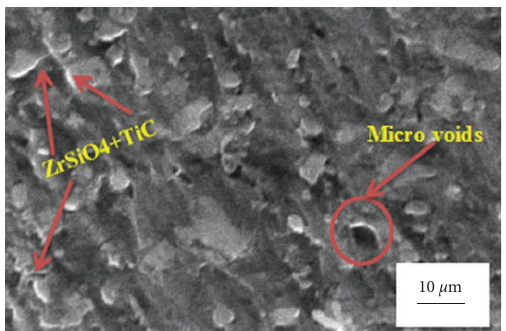
Figure 11: SEM image of experiment no. 12 (combined parameters of FE3-VO4-EL4-ED2).